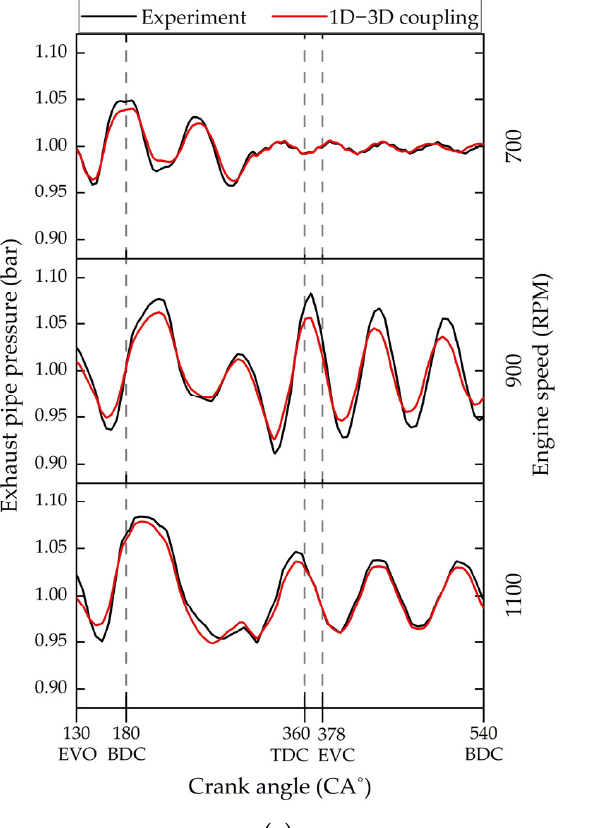
Table 5. Timing of the peak after EVC according to the engine speed. Engine Speed (RPM)